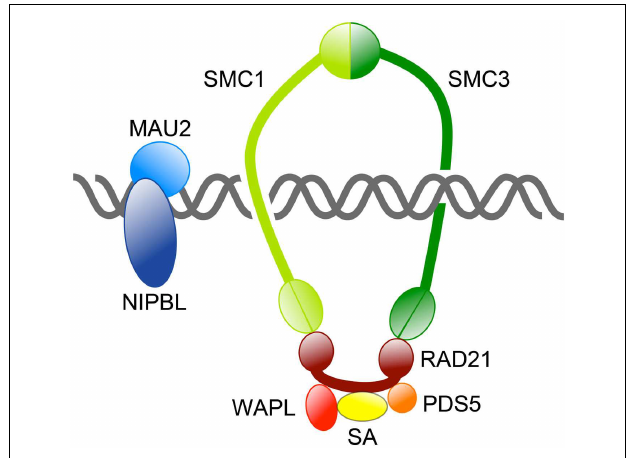
FIGURE 1 | Overview of the cohesin complex and its associated proteins. The cohesin complex consists of four core subunits: SMC1, SMC3, RAD21, and SA.Together these subunits form a large ring capable of topologically encircling DNA strands. Other proteins regulate cohesin’s binding to DNA and its residency there.The NIPBL/MAU2 dimer loads cohesin onto DNA, whereasWAPL/PDS5 release cohesin from chromosomes by opening the SMC3-RAD21